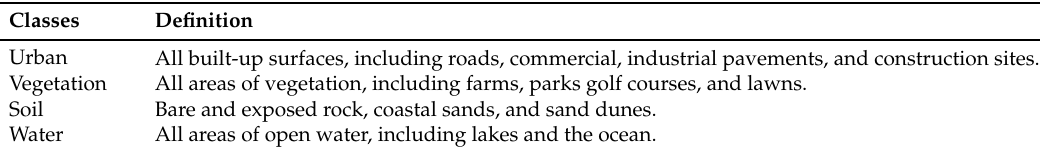
Table 1. Land use/cover classes and definitions used in this